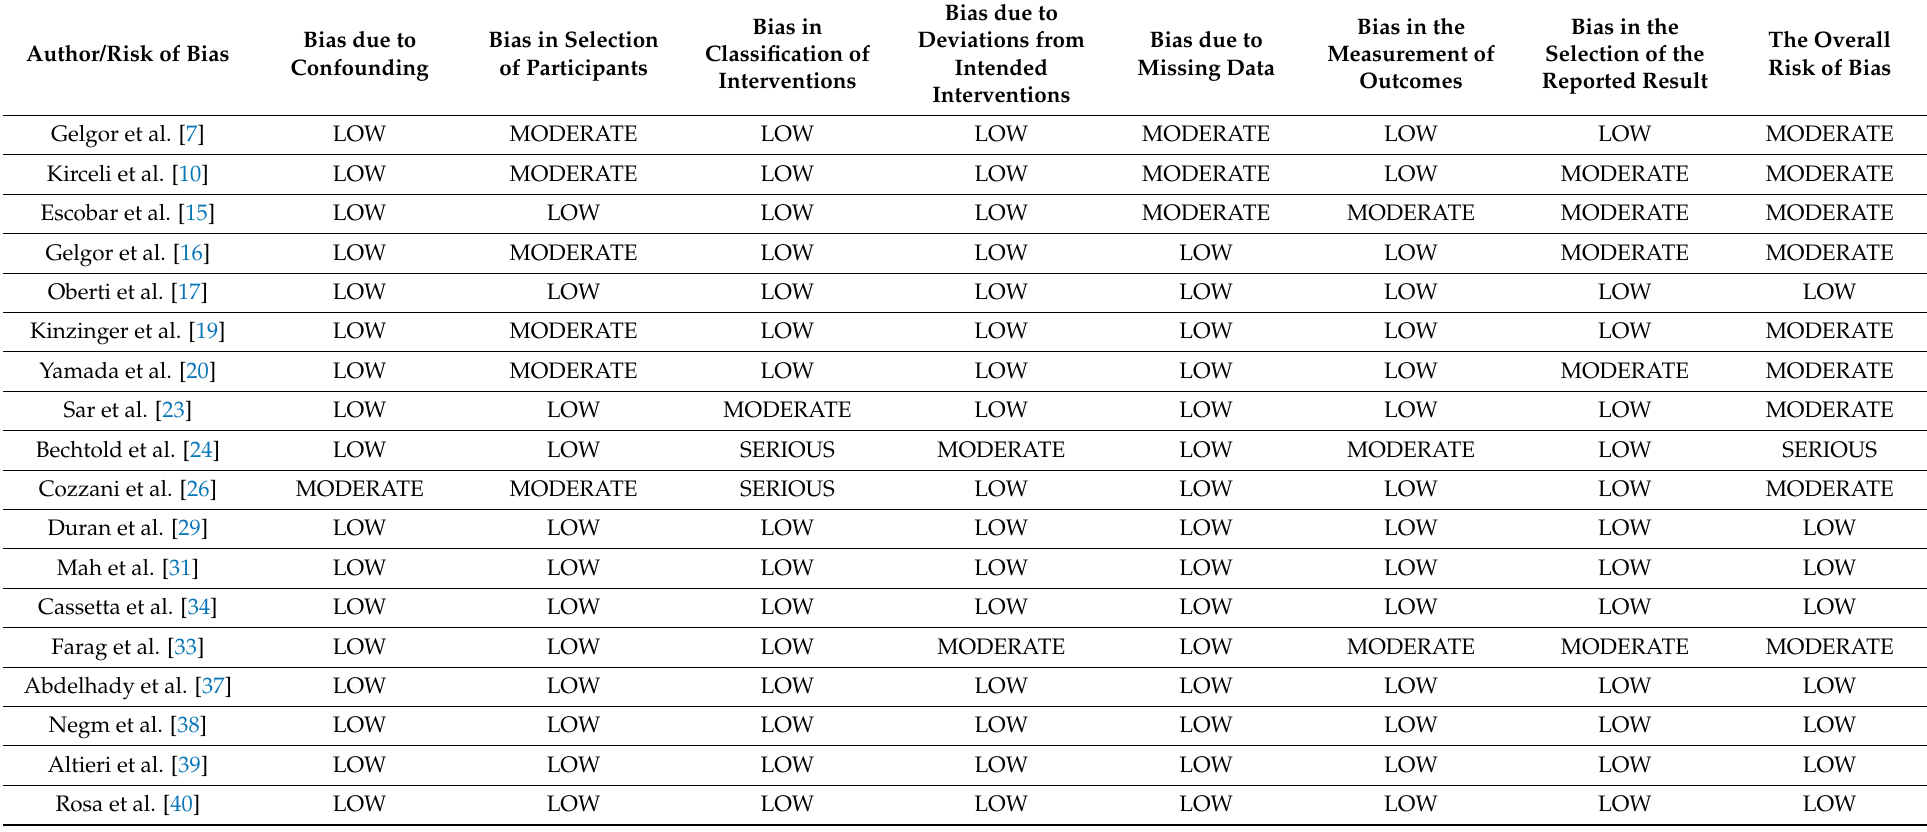
Table 2. Risk of bias in non-randomized studies used for the systematic review (ROBINS-I assessment